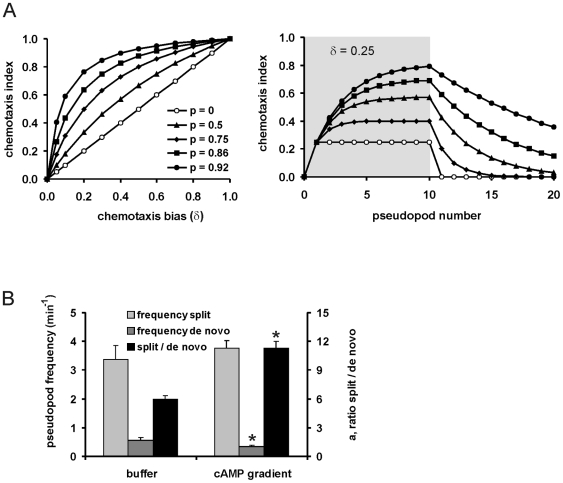
Role of persistence in chemotaxis.A. Theoretical analysis of persistence and chemotaxis bias on chemotactic movement towards the gradient (see supplemental information appendix S1 for equations). In the absence of persistence the chemotactic response is immediate and identical to the chemotactic bias. With persistence the response slowly increases to a higher steady state and persists after removal of the gradient. At the measured [36] threshold for chemotaxis with δ = 0.1, the observed persistence of p = 0.92 for wild type cells will lead to a ∼5-fold increase of chemotaxis index. B. Effect of a cAMP gradient on the frequency of pseudopod splitting and de novo pseudopodia. Data are means and SEM, n = 28 cells; *, significantly different from buffer at P<0.01. The ratio (a) of splitting/de novo pseudopodia is related to the persistence (p), according to p = a/(1+a).